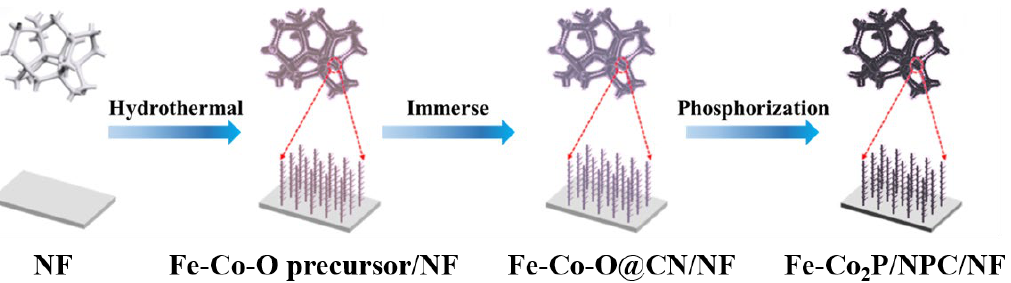
Scheme 1. Schematic illustration of the preparation process of Fe-Co 2 P/NPC/NF.